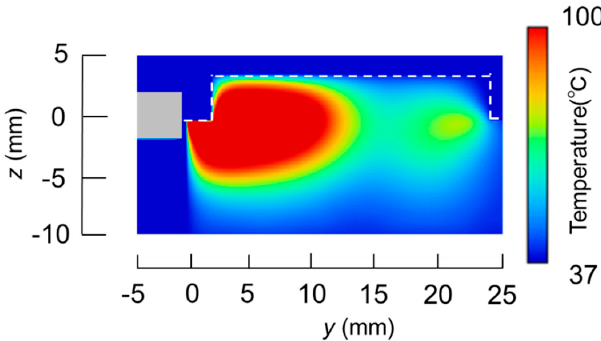
Diagnostics 2018 , 8 , x FOR PEER REVIEW Figure 7. Temperature distributions of the high frequency snare at x = 0 mm. Figure 7. Temperature distributions of the high frequency snare at x = 0 mm.